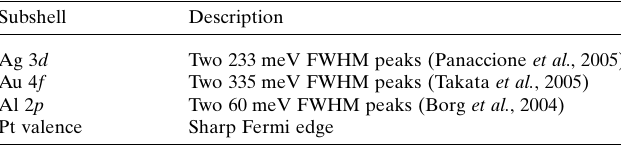
Table 1 Description of photoemission from some electronic subshells of solids. Subshell